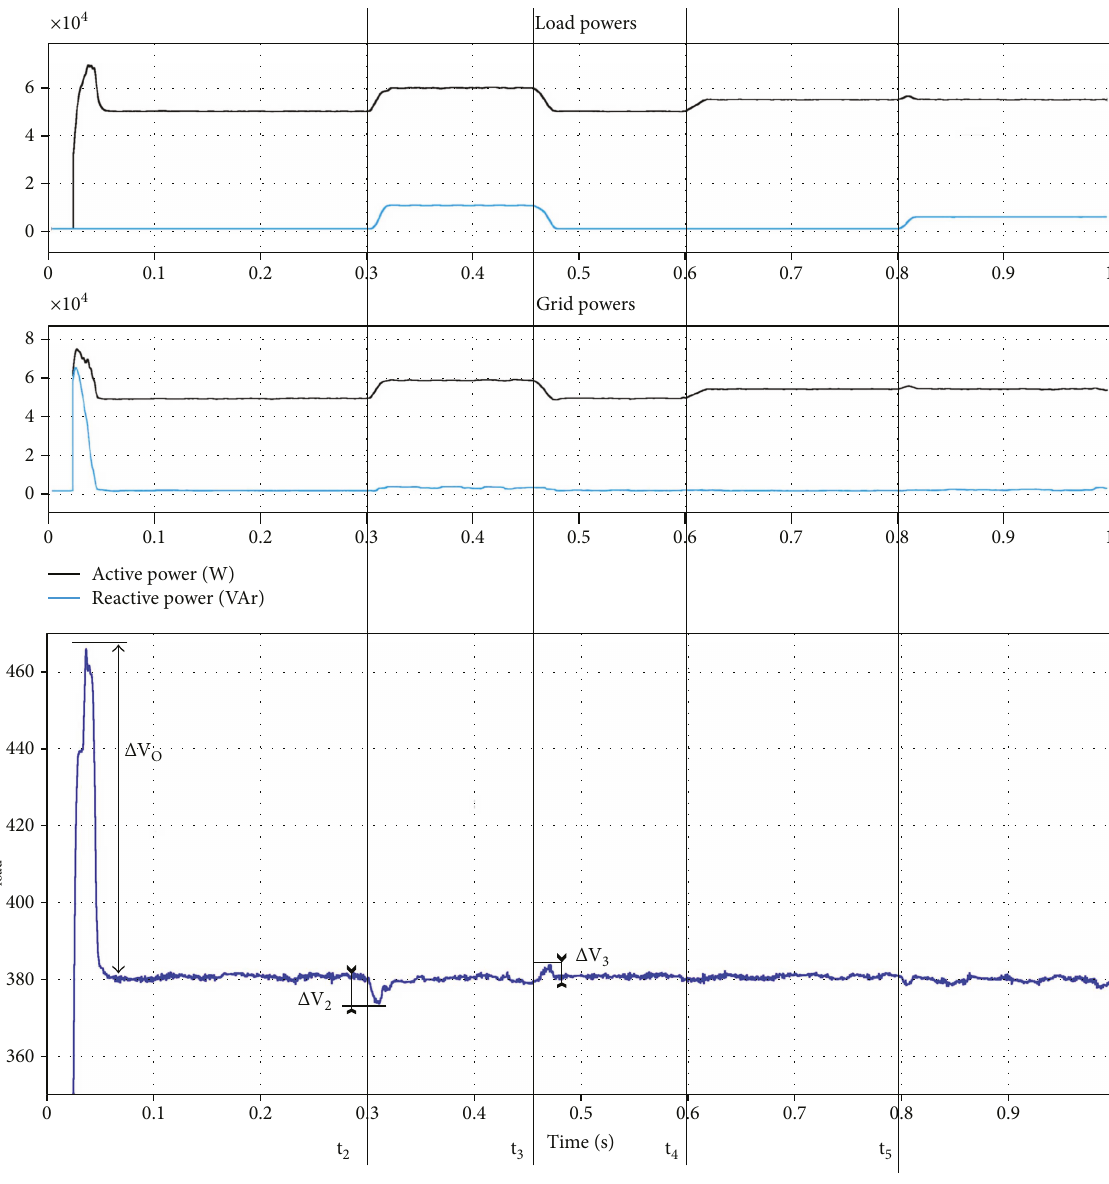
Figure 12: Reactive power compensation when the STATCOM device with a PI controller is enabled and voltage change on loads.